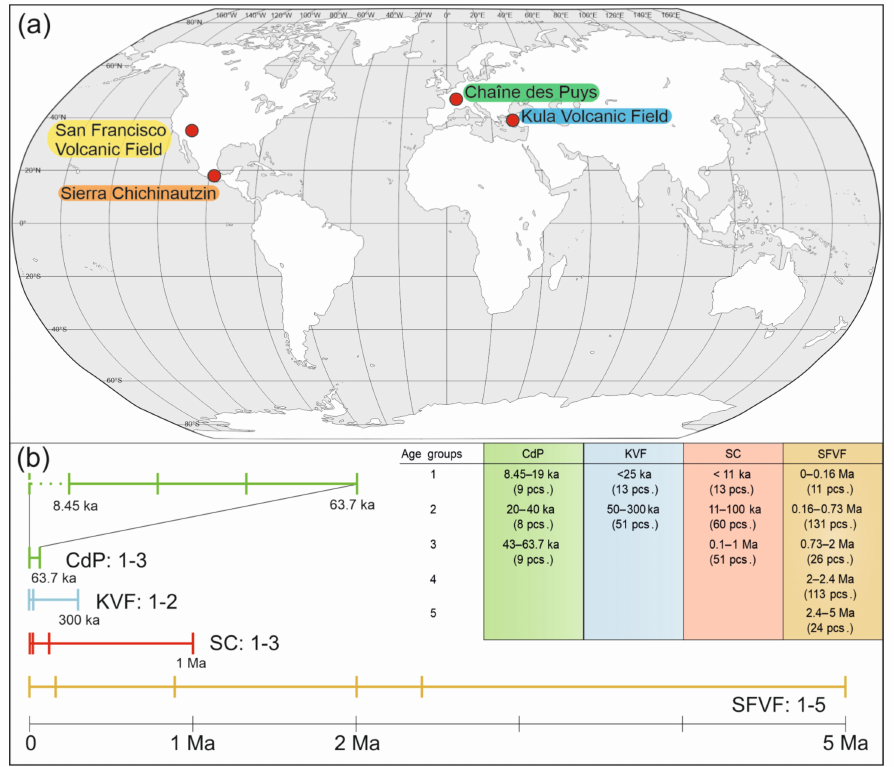
Figure 2. ( a ) Location and ( b ) age scales and groups of the examined four volcanic